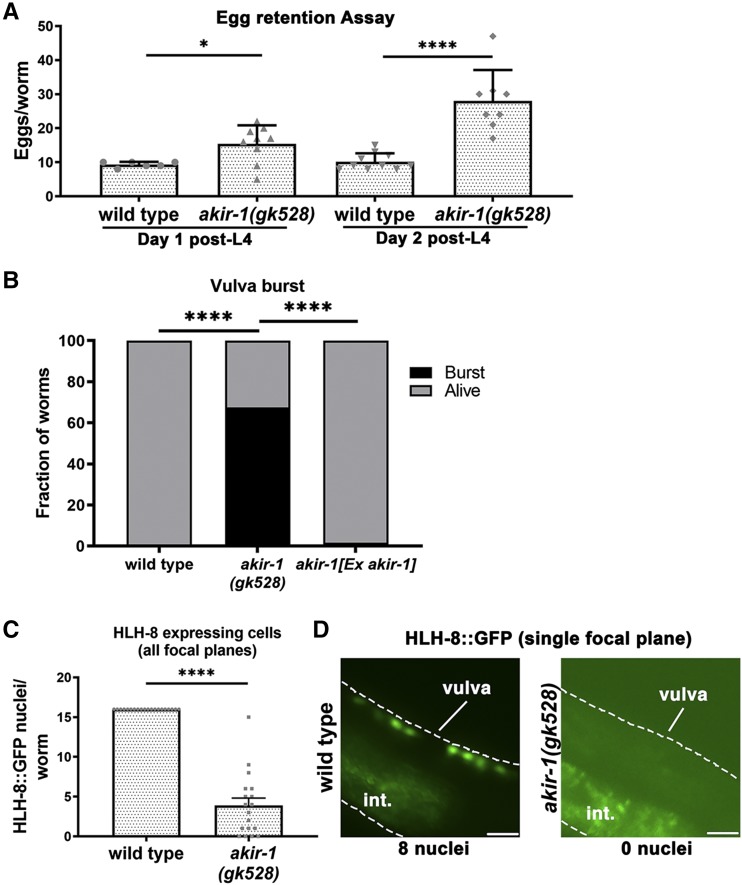
AKIR-1 is required for proper vulvar development and function. A) Eggs retained in the uterus at 1 and 2 days post-L4, mean plus SEM shown. Wild type day 1 n = 6 and day 2 n = 10, akir-1(gk528) day 1 n = 9 and day 2 n = 8. B) Rates of vulvar burst were measured. Wild type did not display incidences of vulvar tearing (0%, n = 84), akir-1(gk528) counts had n = 77. Expression of AKIR-1 from a wild type akir-1 gene in an extra-chromosomal array showed rescue of vulvar tearing (2%, n = 57). C) HLH-8 expressing myoblasts present in wild type L4 animals n = 20 and akir-1(gk528) n = 18. D) Images of HLH-8 expressing myoblasts in L4 animals in normal, edge-on configuration in wild type and their absence in akir-1(gk528). One focal plane is presented which contains half (8) of the HLH-8 nuclei. Dashed lines are where the borders of the worm body are. The normal position of the vulva is indicated, as is the intestine displaying normal autofluorescence. Scale bars 10μm. * 0.01 ≤ P ≤ 0.05, *** 0.0001 ≤ P < 0.001.